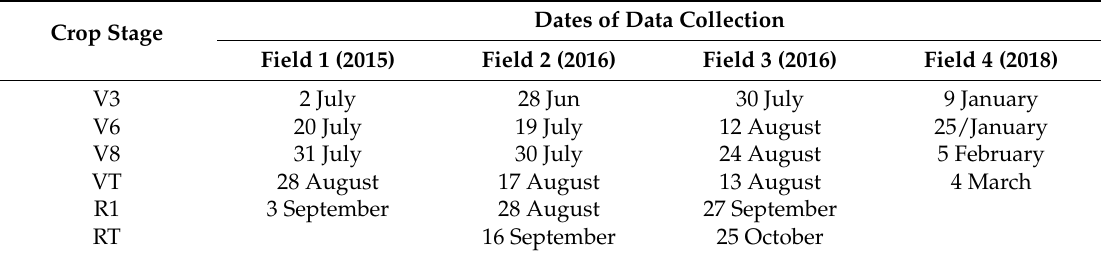
Table 2. Dates of field leaf area index collection and corresponding crop phenological stages. Crop